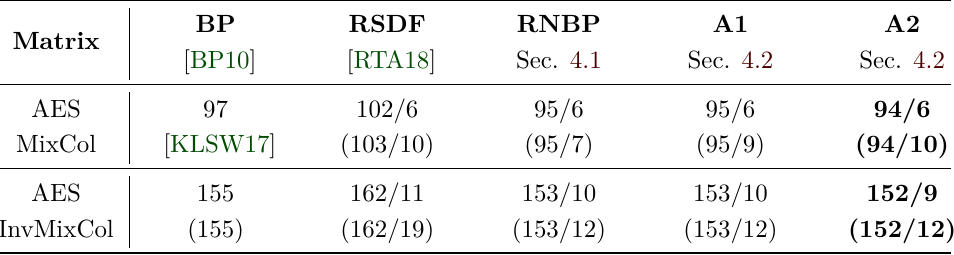
Table 8: AES diffusion matrix circuit cost (XOR/Depth) with several algorithms. The values in bracket are the BLOY